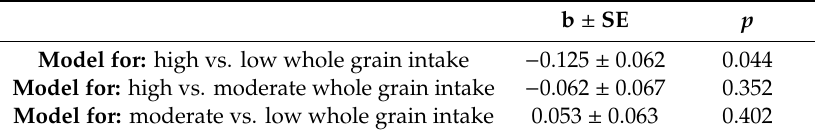
Table 3. Results from linear regression models that evaluated the association of whole grain intake on CVD risk factor score (outcome) among ATTICA ( n = 1128) and MEDIS ( n = 2221) study participants. b ± SE p Model for: high vs. low whole grain intake − 0.125 ± 0.062 0.044 Model for: high vs. moderate whole grain intake − 0.062 ± 0.067 0.352 Model for: moderate vs. low whole grain